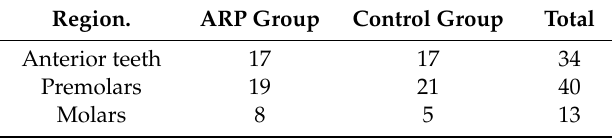
Table 1. Distribution of the teeth of 87 patients according to their positions in the jaw. Region. ARP Group Control Group